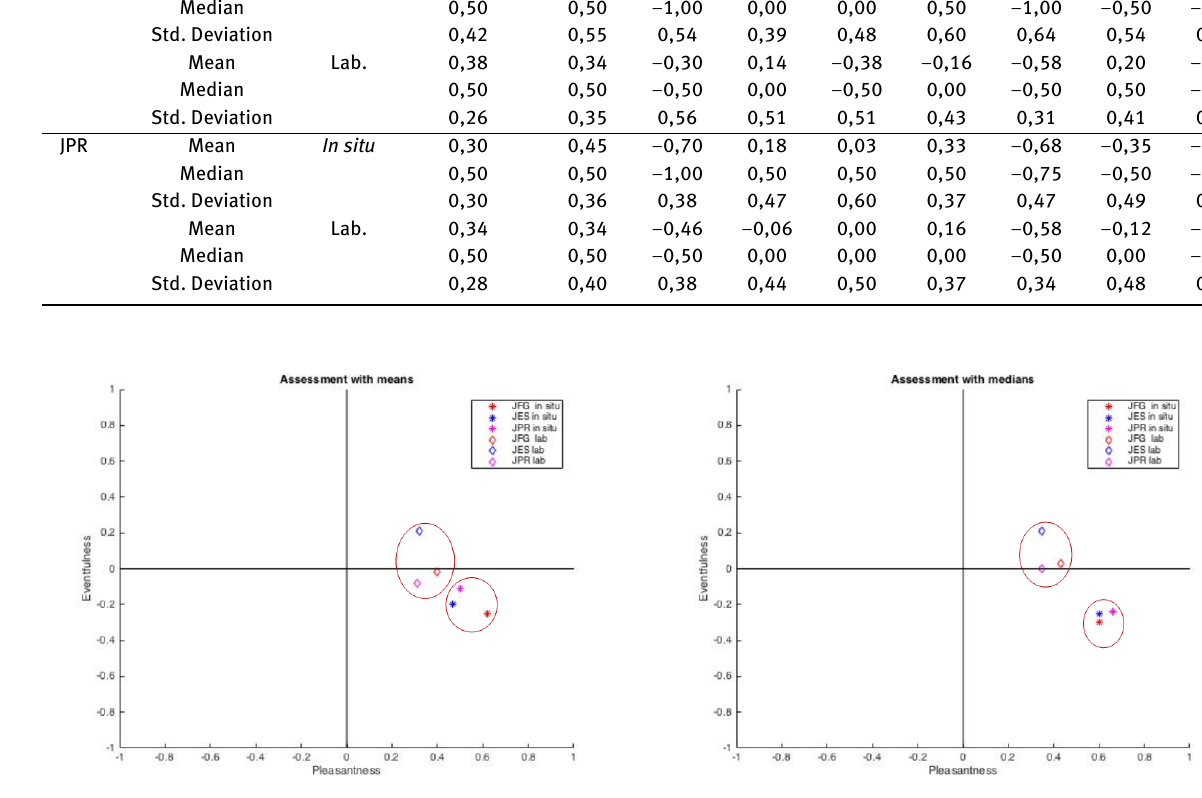
Figure 5: Graphical representation of the evaluation of urban parks Figure 6: Graphical representation of the evaluation of urban parks in the city of Lisbon, using the medians for measure of central ten-